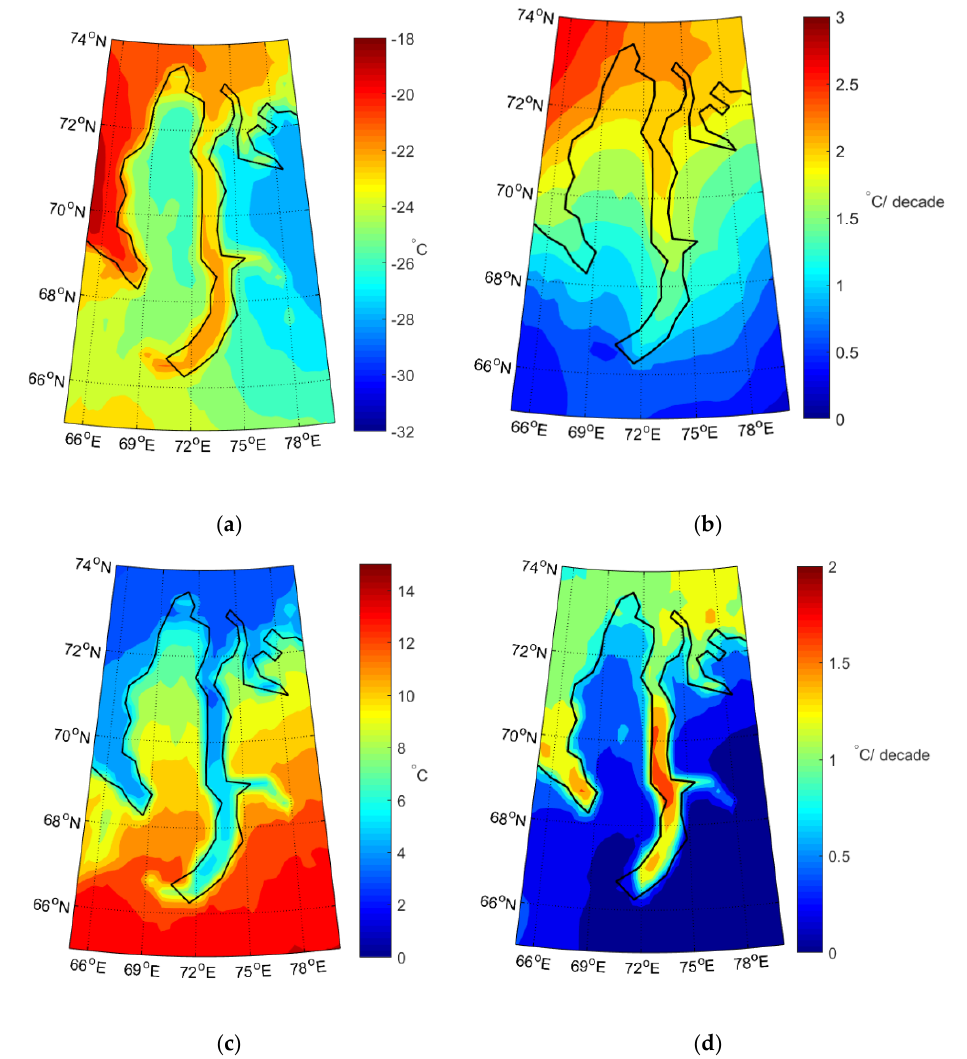
Figure 2. Mean surface (2 m) air temperature (°C) ( a , c ) and linear trend (per decade) ( b , d ) in January ( top ) and in July ( bottom ) based on ERA5 Reanalysis for 1985–2019.